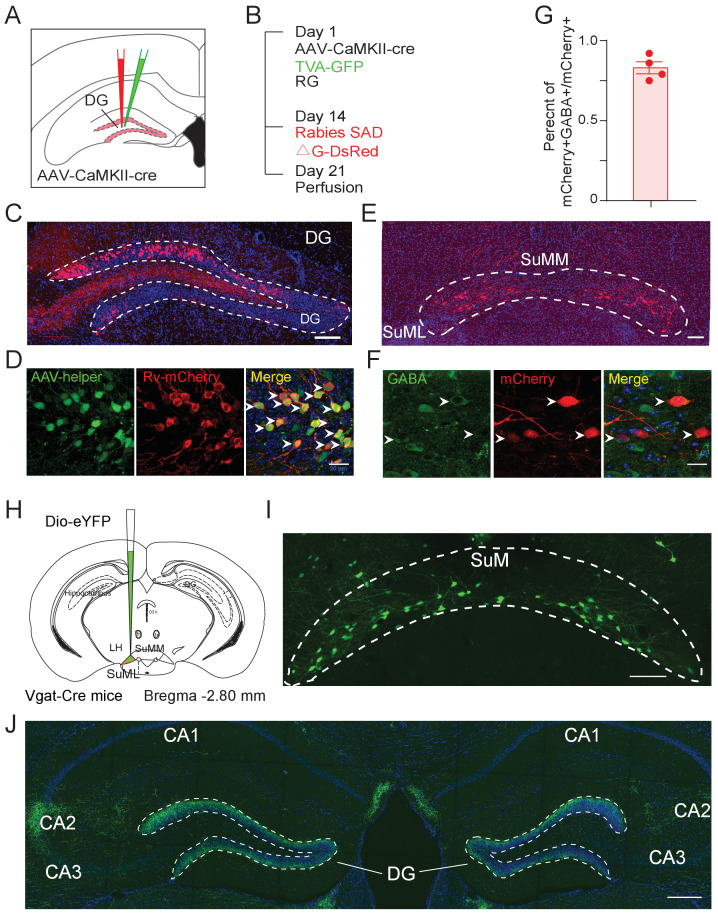
Cell-type-specific anterograde and retrograde tracing for SuMVgat-DG connections.(A) Diagram of rabies-based monosynaptic synaptic tracing of DG GCs. (B) Experimental timeline of retrograde tracing. On day 1, AAV-CaMKII-Cre, Cre-dependent TVA-GFP and RG virus were injected to the left DG. On day 14, Rabies-mCherry was injected at the same site and mice were perfused on day 21. (C) Fluorescence images showing starter cells with mCherry expressions in the DG. Scale bar = 100 µm. (D) Amplified starter cells in the DG. Zoomed-in view of injection site showing that starter neurons (yellow, arrows indicated) were infected with AAV helper virus (green) and RV (red). Scale bar = 20 µm. (E) Representative coronal section showing retrogradely RV-labeled cell bodies (red) were in the SuM, with dense mCherry+ cells in the lateral SuM (SuML) and sparse mCherry+ cells in the medial SuM (SuMM). Scale bar = 100 µm. (F) RV-labeled SuML neurons were positive for GABA staining (white arrows indicated). Scale bar = 20 µm. (G) Percentage of retrograde labeling mCherry+ cells co-localized with GABA staining in the SuML. (H) Diagram of anterograde tracing. AAV5-DIO-eYFP was delivered to the SuML in Vgat-Cre mice. (I–J) Fluorescence images showed SuML projections located in the DG and CA2. Scale bar = 200 µm.